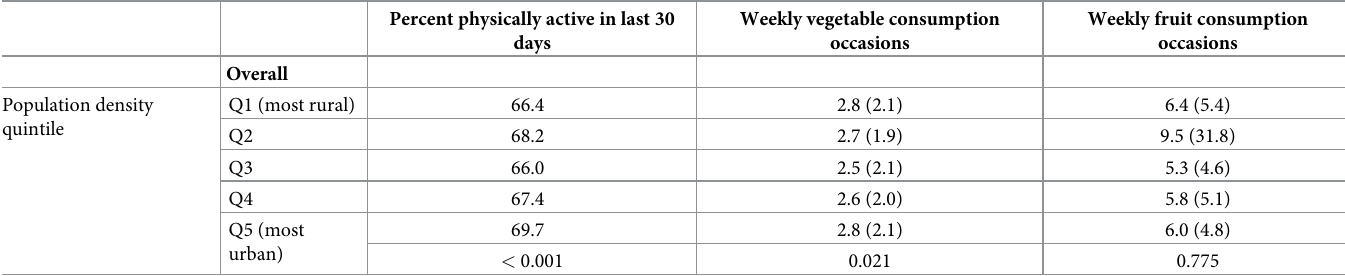
Table 2. Frequencies and descriptive statistics of physical activity and fruit and vegetable consumption by population density